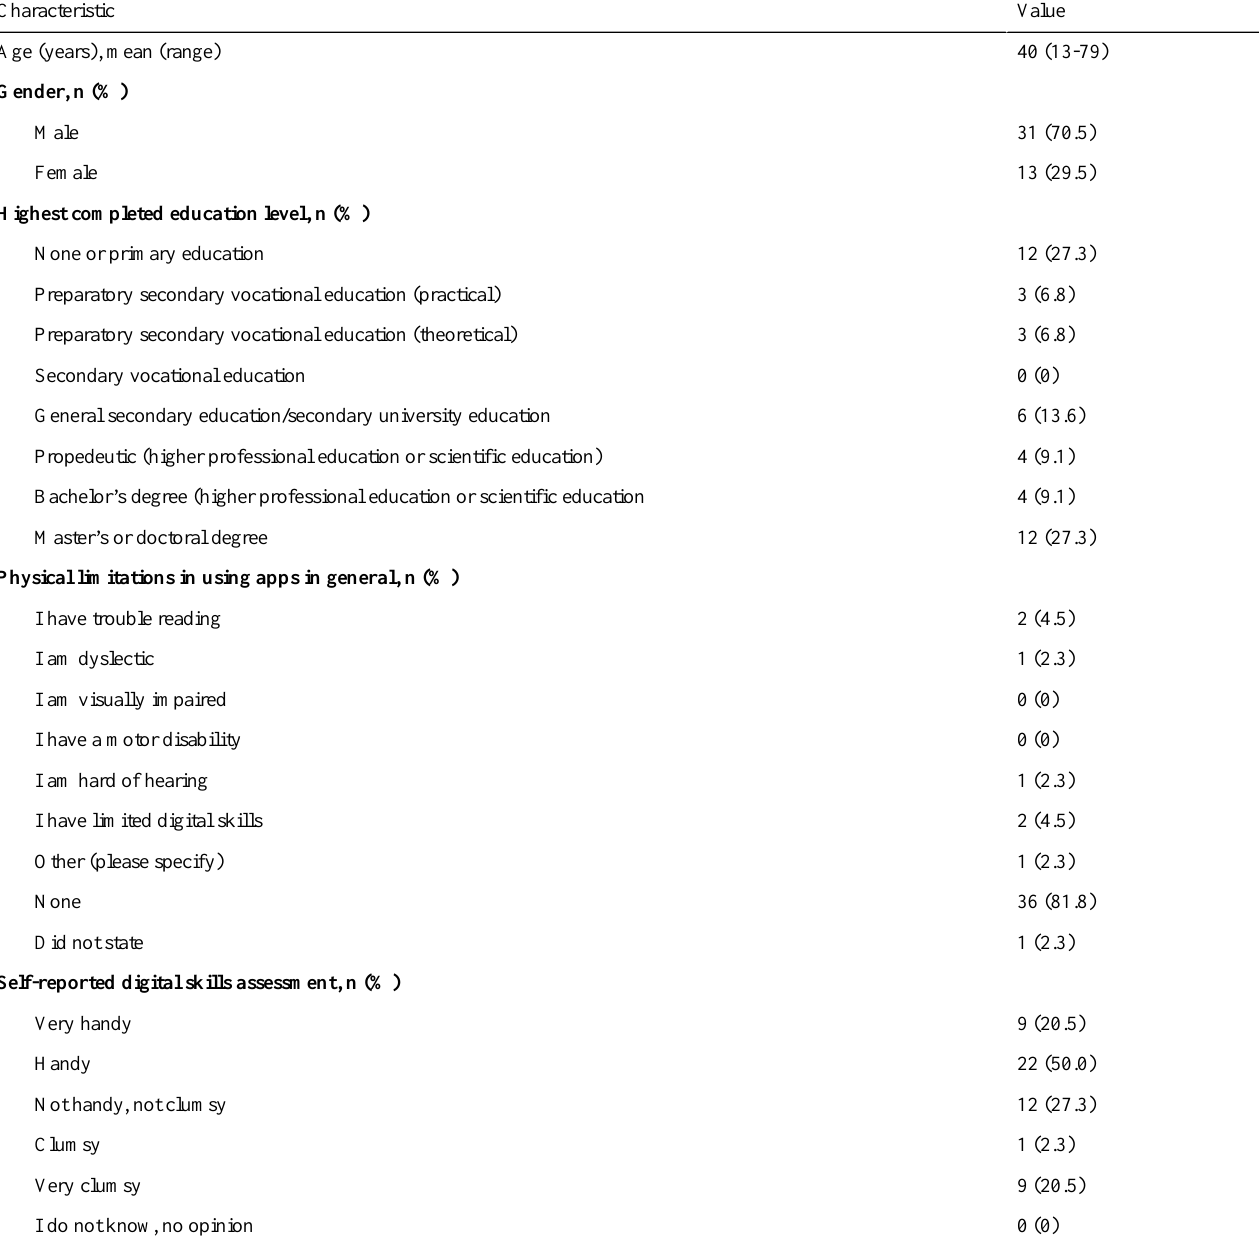
Table 1. Demographic data of participants (N=44).